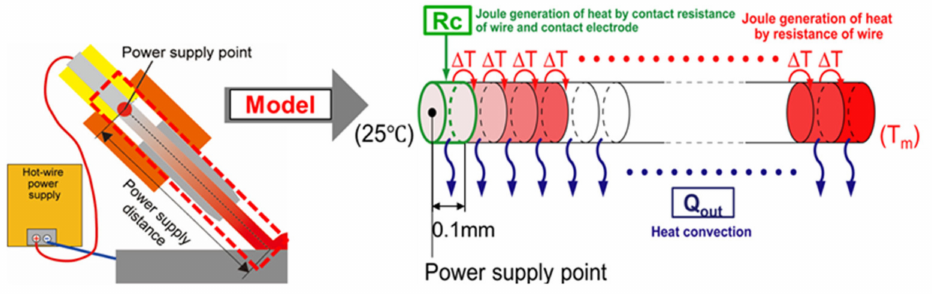
Figure 4. Schematic diagram of simple current calculation method for appropriate hot-wire